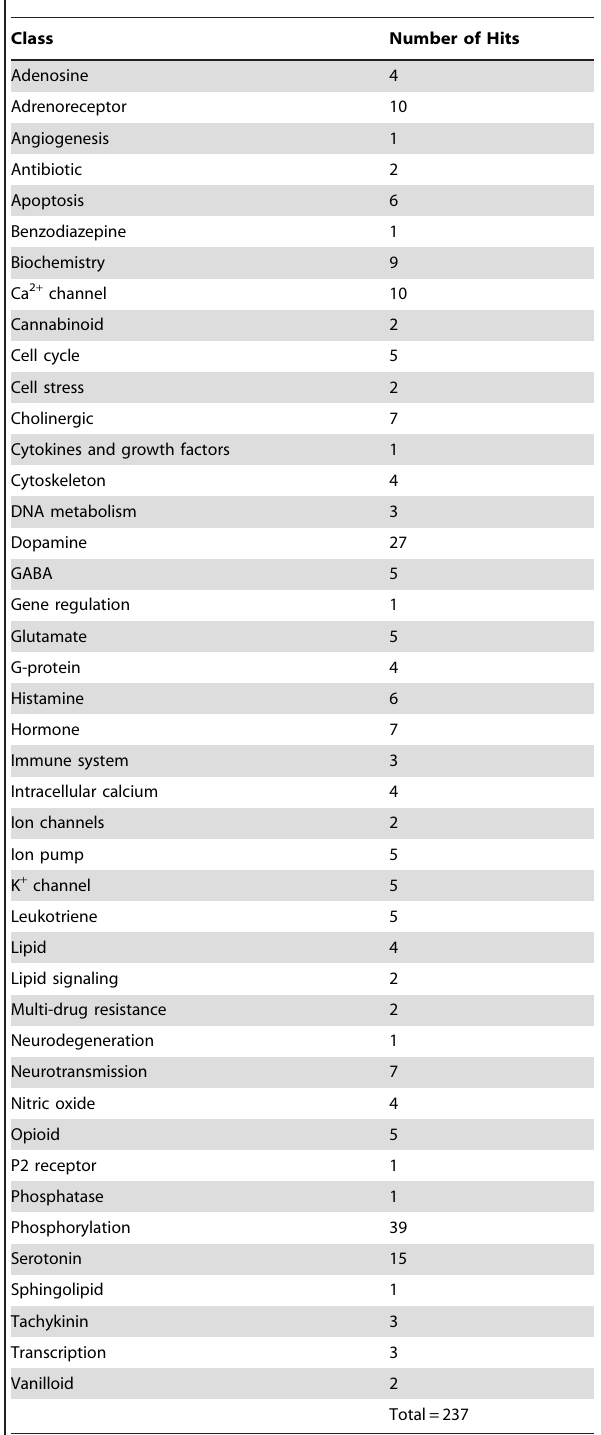
Table 1. Classes of compounds that inhibit SCLC cell